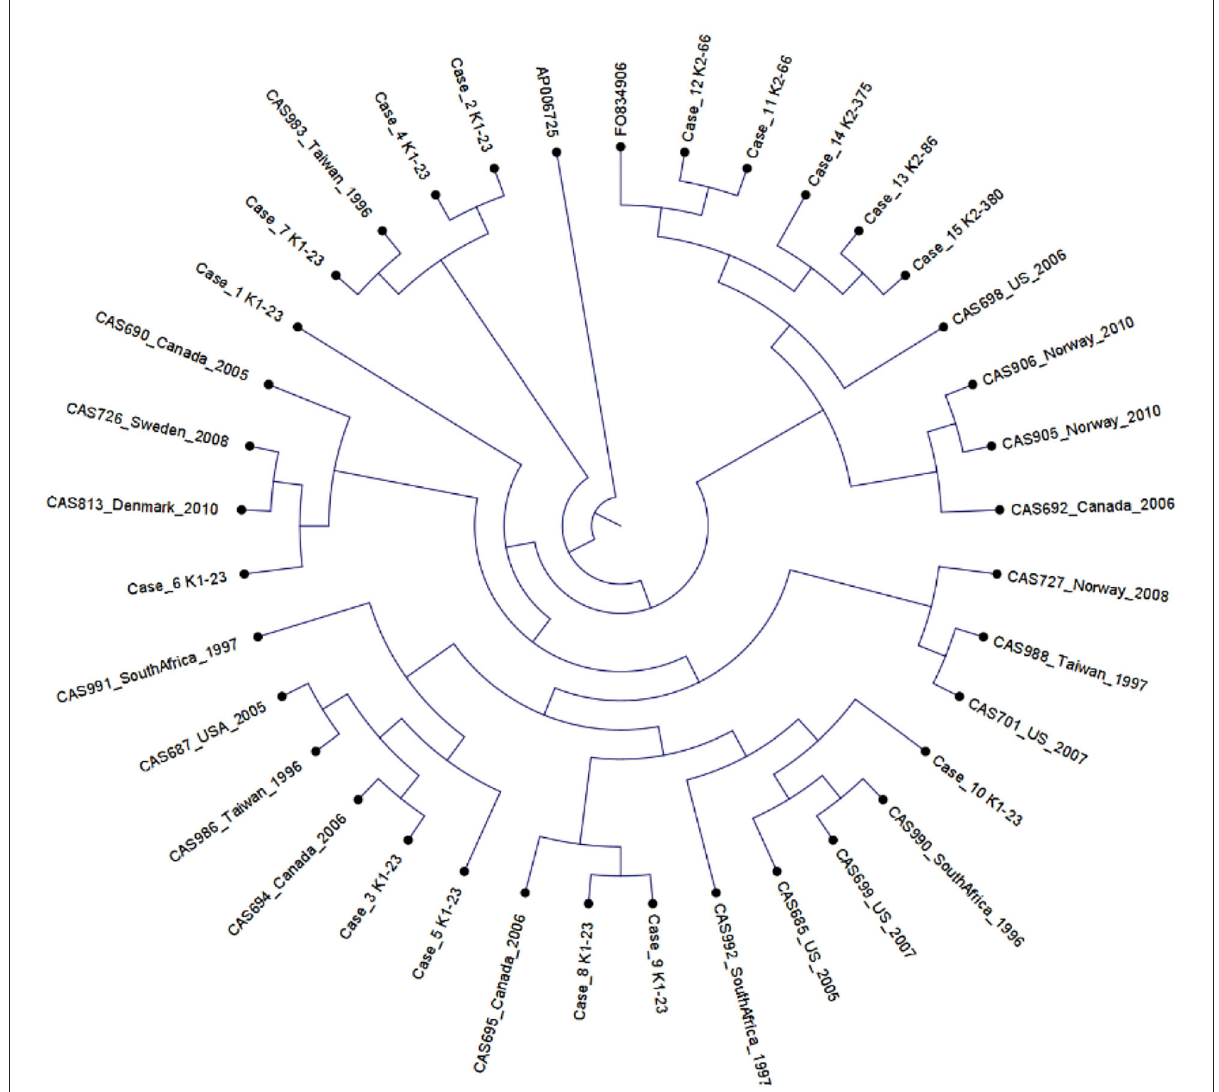
FIGURE2 Phylogenetic analysis of 20 K1-ST23 isolates from different geographical origins labeled with country of origin and year of sampling (Lin et al., 2012), 10 K1-ST23 isolates from our study population, and two references strains; K1 serotype (AP006725) and K2 serotype (F0834906).